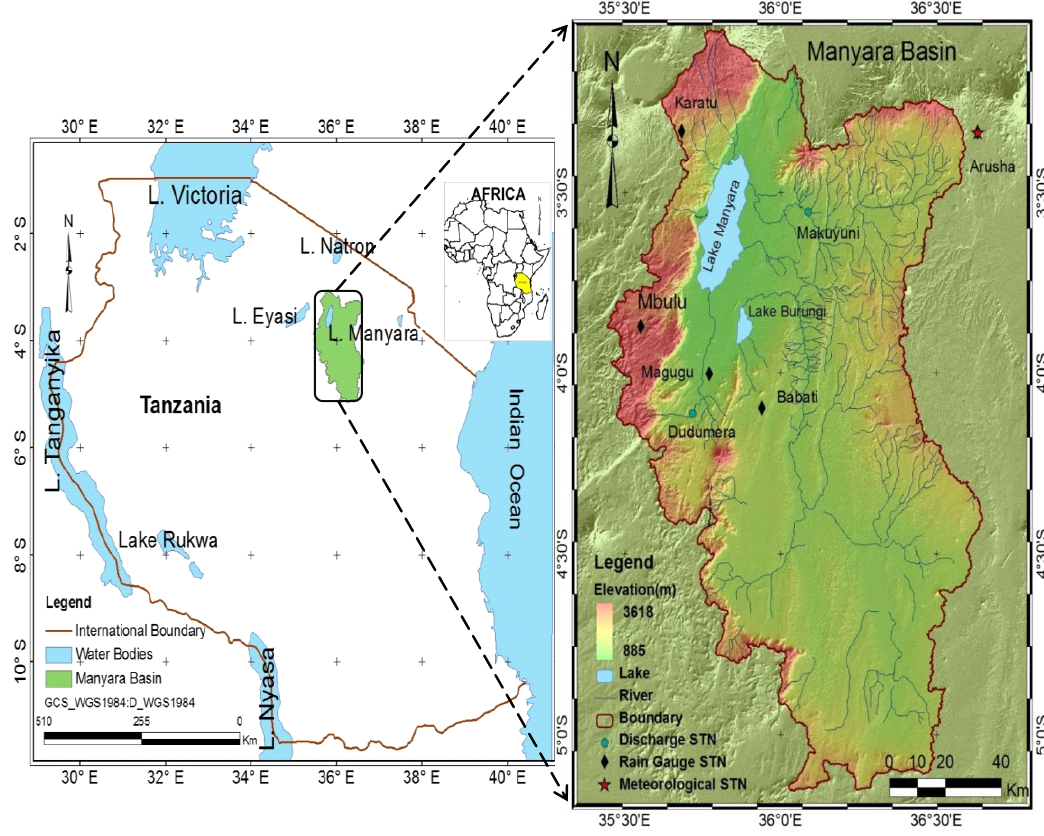
Figure 1. Lake Manyara and its catchment basin in northern